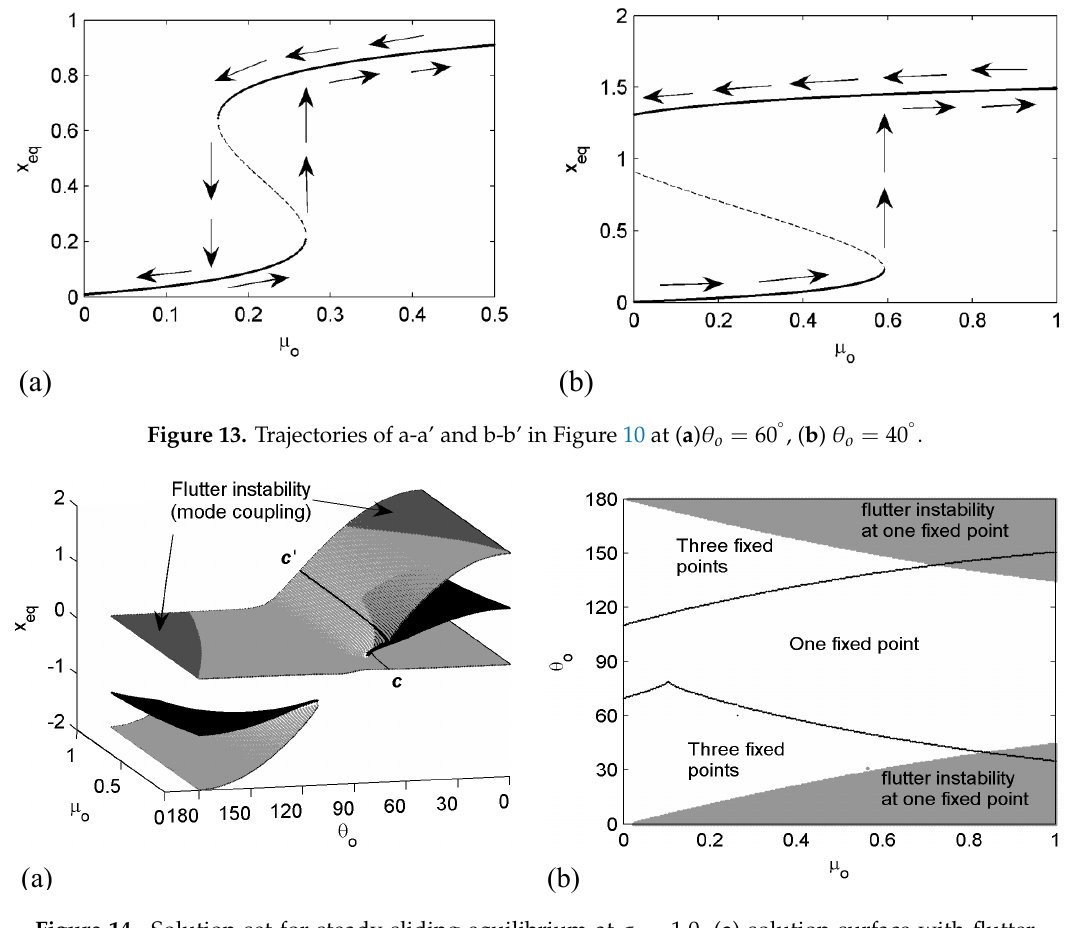
Figure 14. Solution set for steady-sliding equilibrium at σ = 1.0, ( a ) solution surface with flutter instability, ( b ) bifurcation set.